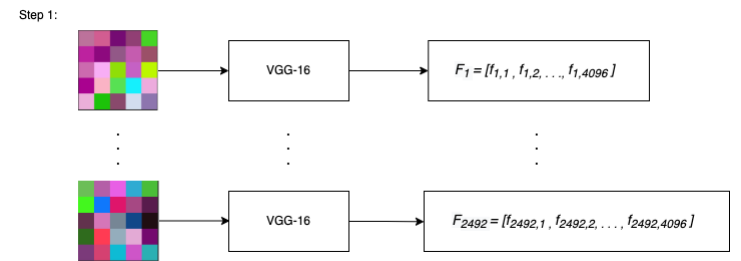
Figure 4. Images of size 5 × 5 passed through VGG-16 resulting in F 2492 × 4096